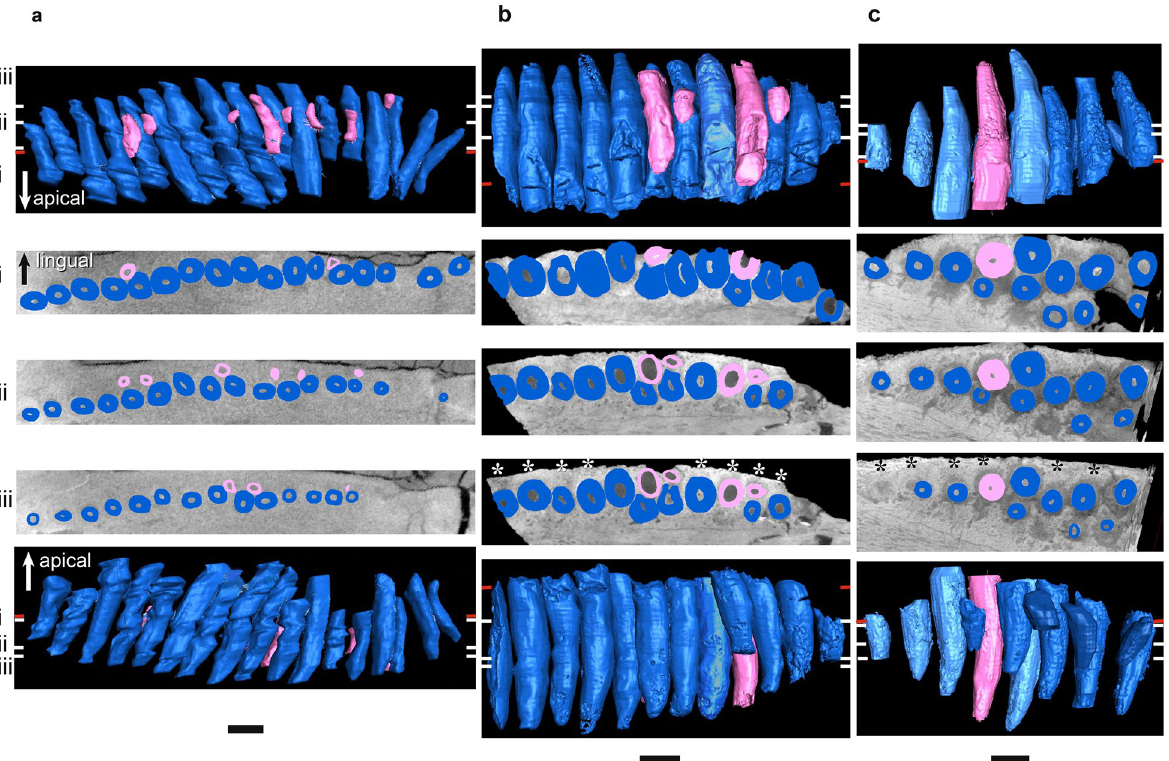
Figure 7. µCT scans of Endothiodon mandibular ‘postcanine’ teeth in horizontal section (middle three rows), lingual view (top row), and labial view (bottom row). ( a ) Endothiodon tolani NHCC LB684 (mirrored), ( b ) Endothiodon bathystoma NHCC LB816 with partial multiple rows (mirrored), ( c ) Endothiodon bathystoma NHCC LB11 with multiple rows (mirrored). Horizontal sections were taken at numbered positions indicated on the labial and lingual views. The level of the gumline is indicated by a red tick mark on labial and lingual views. Replacement teeth are highlighted in light pink and functional teeth in medium blue. Anterior is to the left. Scale bars 5 mm. Asterisks indicate visible alveolar bone